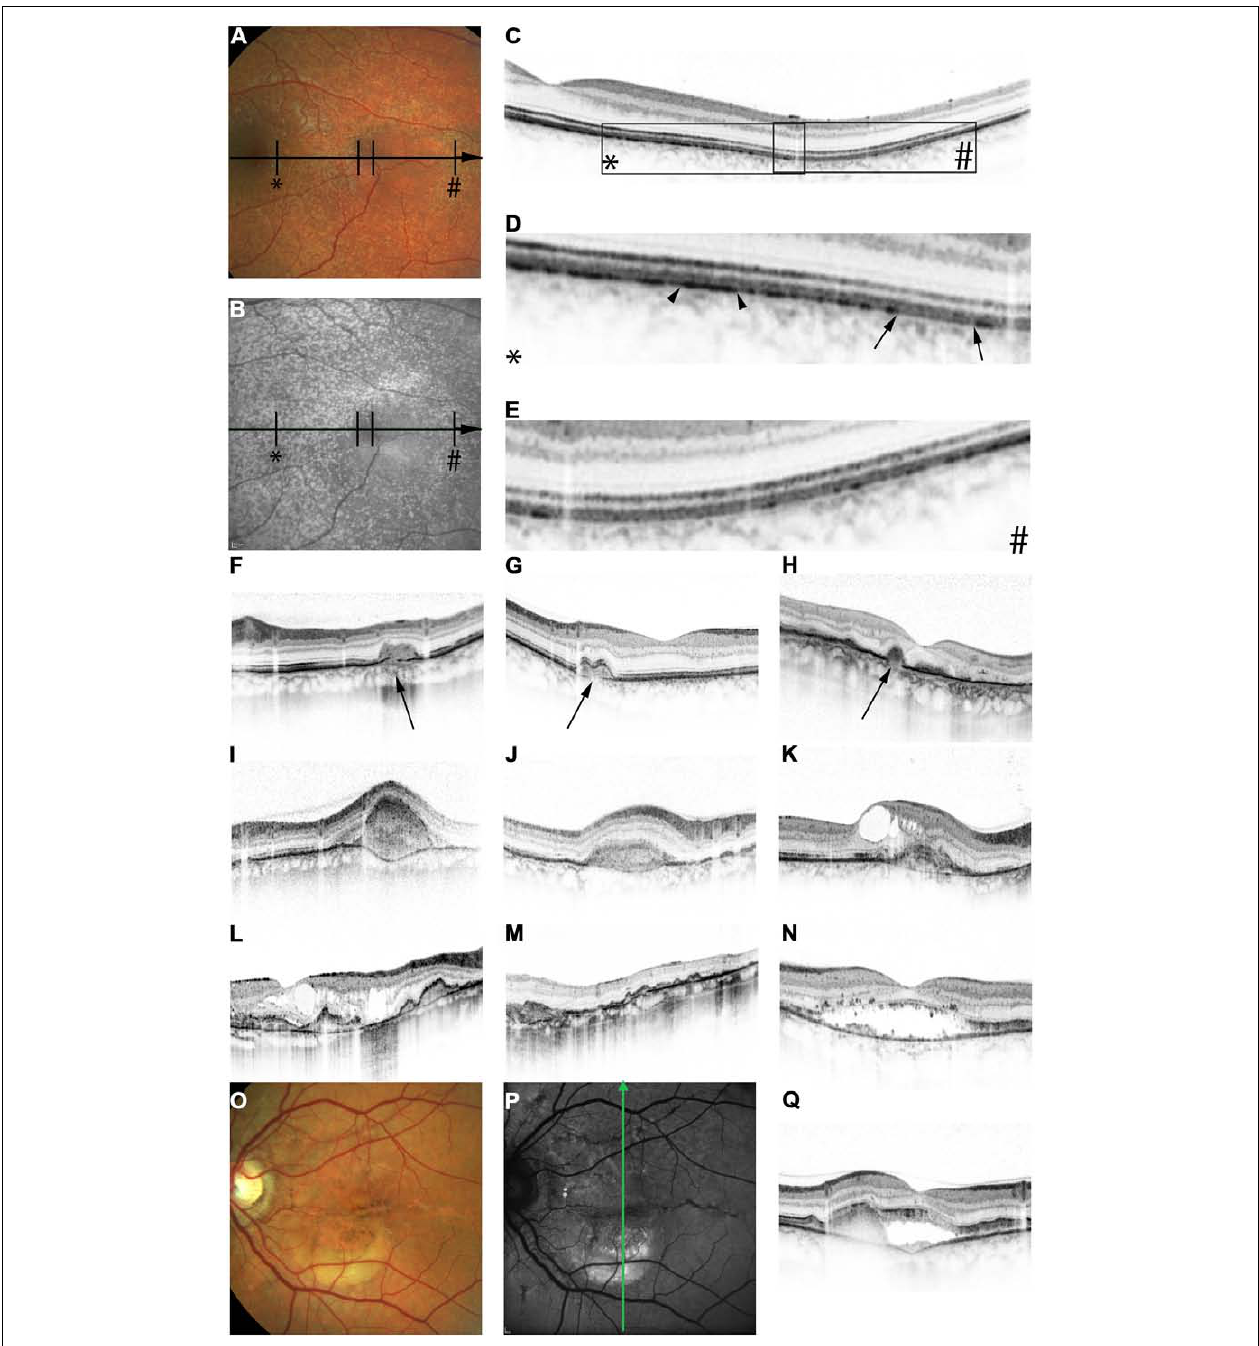
FIGURE 2 | Features of pseudoxanthoma elasticum on optical coherence tomography. Calcification of Bruch’s membrane may be seen on OCT images.This is best illustrated within areas of peau d’orange, the transition zone between calcified and un-calcified Bruch membrane (A–E) .The horizontal arrow in (A) and (B) indicates the placement of the OCT scan in (C) . 2.5x magnifications of characteristic details in (C) are shown in (D,E) . Area * corresponds to (D) and area # to (E) . Areas of increased reflectivity within the outer zone of RPE-Bruch’s membrane complex (arrow heads in D ) correlate to the whitish opaque fundus reflex on color images (A) and the increased signal on near-infrared reflectance images (B) . Areas of lower reflectivity ( E , arrows in D ) correlate to the normal fundus reflex. Angioid